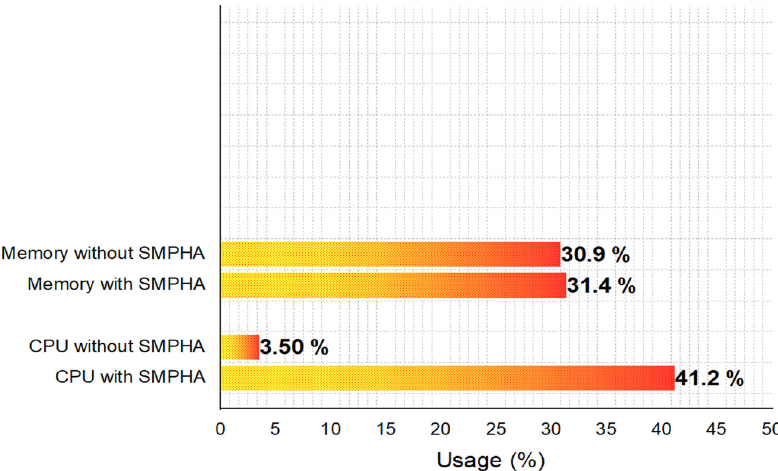
Figure 10: CPU and memory utilization with and without